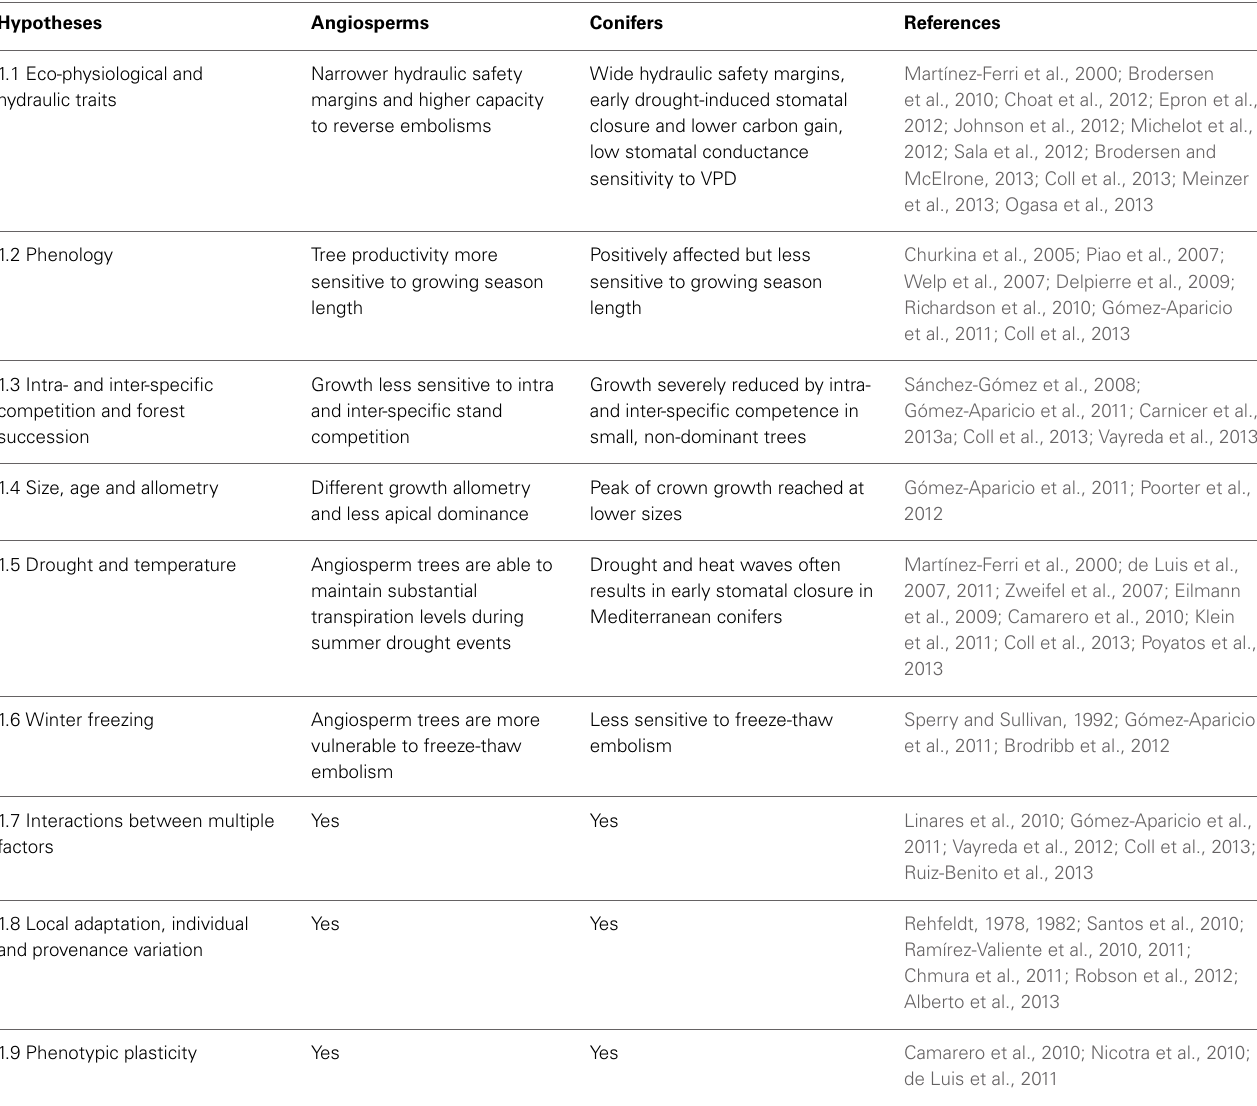
Table 1 | Main hypotheses that may contribute to explain contrasting growth responses to temperature in Iberian Angiosperm and Conifer trees on a large